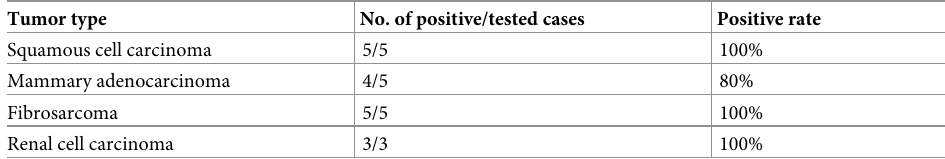
Table 3. Summary of PD-L1 immunohistochemistry in feline malignant